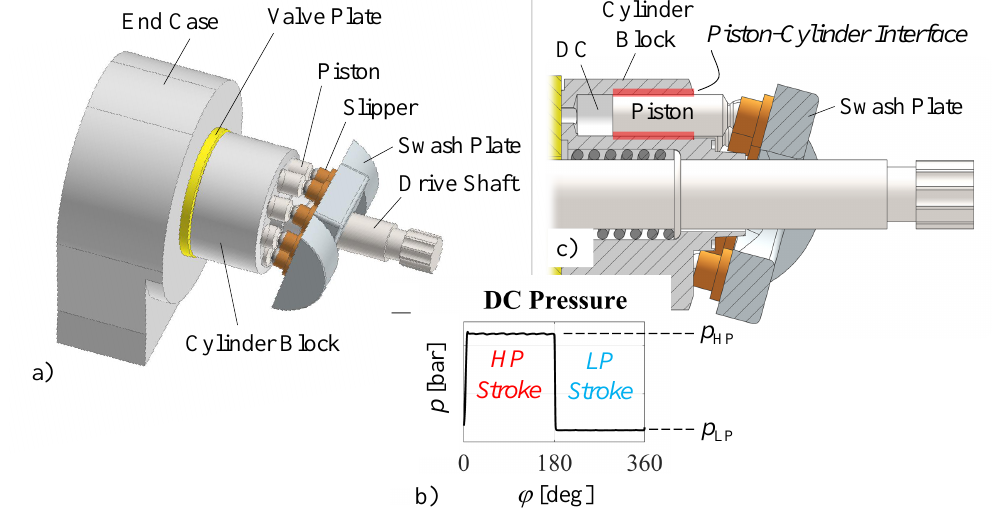
Figure 1. Axial piston machine of swash plate design. ( a ) Components; ( b ) DC pressure; ( c ) Piston-cylinder